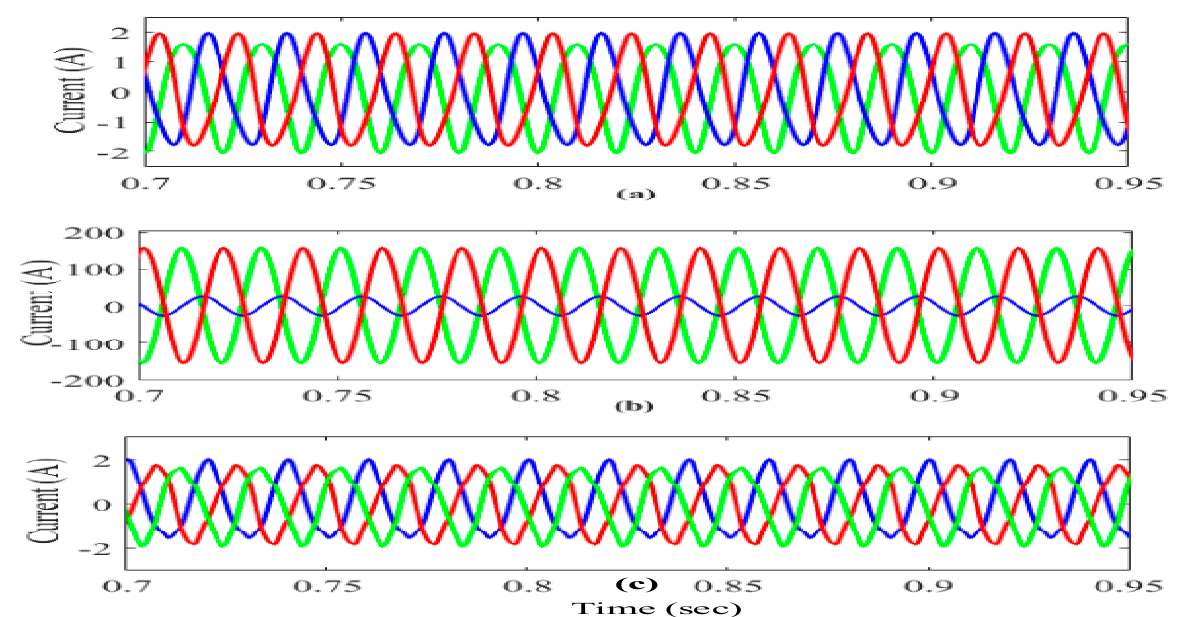
Figure 20. Analysis of current-voltage disturbance conditions ( a ) Source Current ( b ) Load Current ( c ) Injected current.